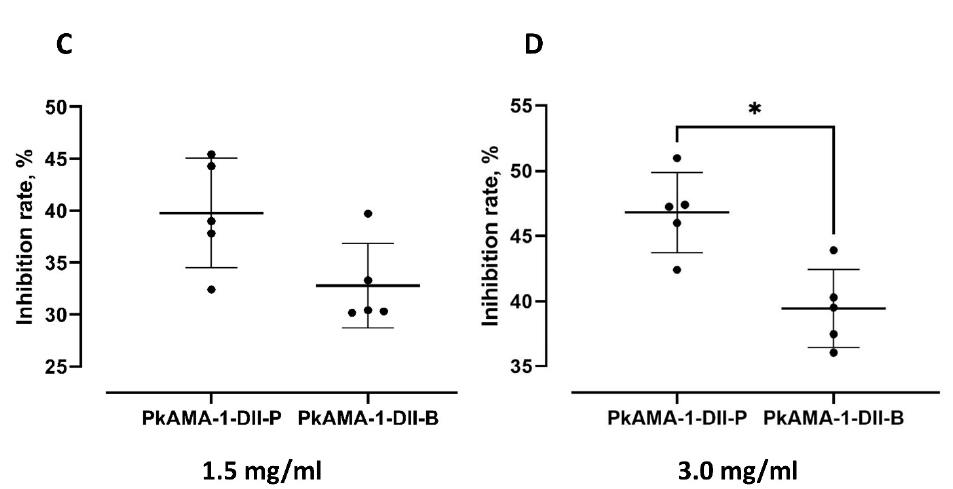
Figure 3. Comparison of merozoite invasion inhibition of anti-PkAMA-1-DII-P and anti-PkAMA-1-DII-B at different concentrations. ( A ) 0.375 mg/mL ( p = 0.4206), ( B ) 0.75 mg/mL ( p = 0.0952), and ( C ) 1.5 mg/mL ( p = 0.0952). ( D ) A significant difference in inhibition was found between both antibodies at 3.0 mg/mL ( p = 0.0159). (* p < 0.05).